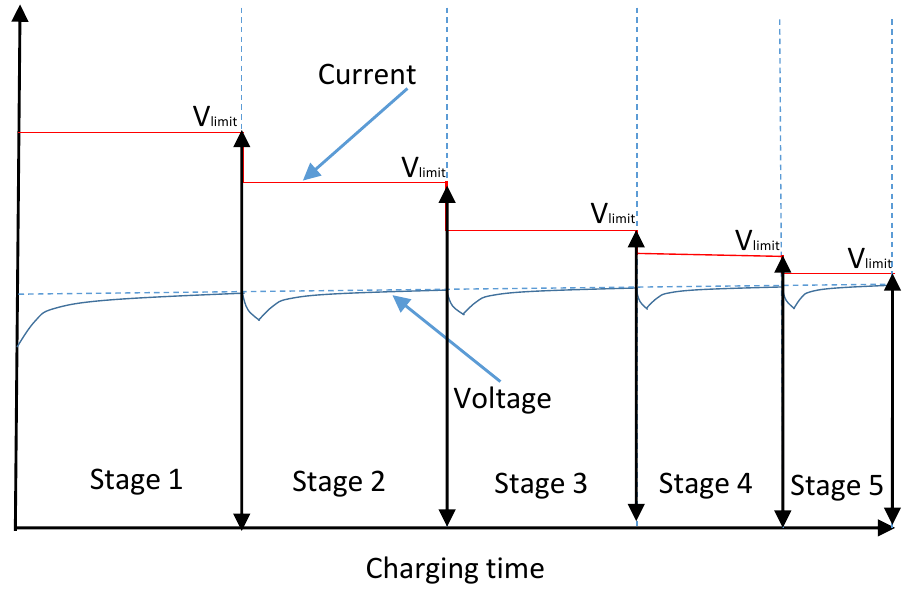
Figure 4. The profile of five stages of current charging